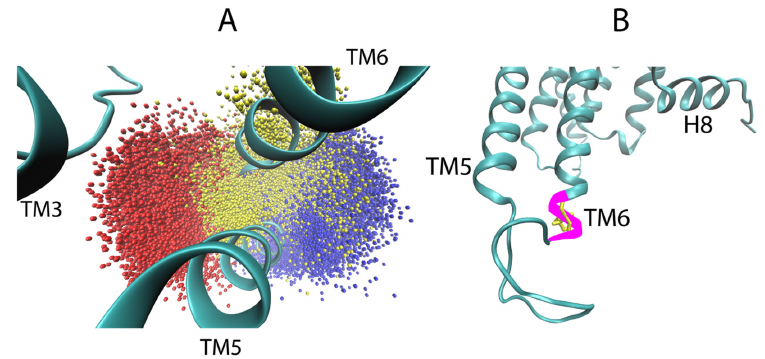
identified as important in the attention map of the partial agonist, but not the full agonist.